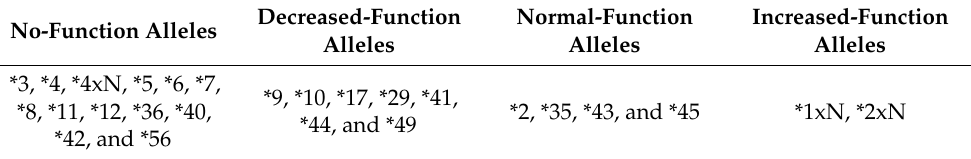
Table 1. CYP2D6 polymorphisms and the enzyme activity